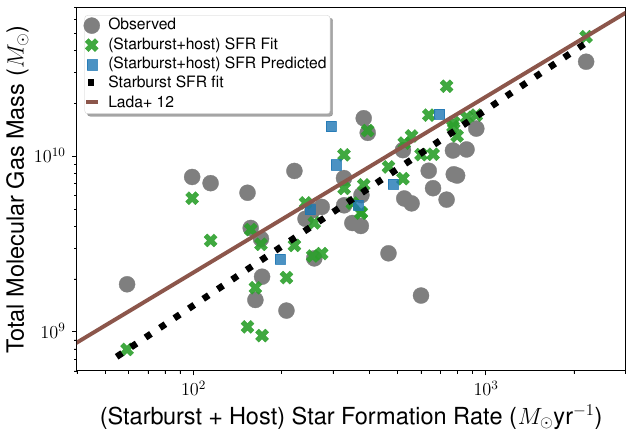
Figure 6. The relation between total SFR and total molecular gas mass (Section 3.4). Overplotted are our starburst SFR— M H fit (Equation (52)), our starburst + host SFR— M H 2 the predicted positions of objects without a CO 1–0 luminosity from Equation (53). Also plotted is the SFR-M H scaling relation from Lada et al. 2